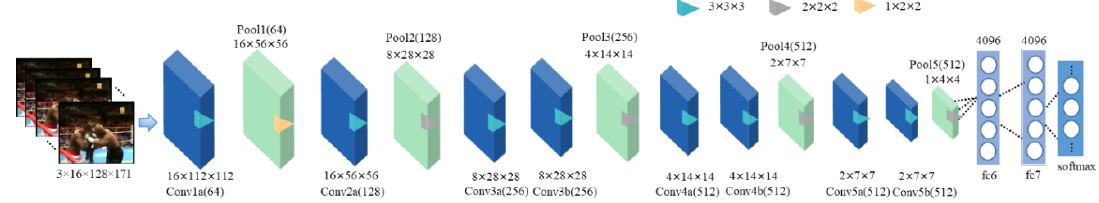
Figure 4. The architecture of C3D containing eight convolutional, five max pooling, and two fully connected layers, followed by SoftMax layer (Output). The three color cones represent the different size of filters for each layer.